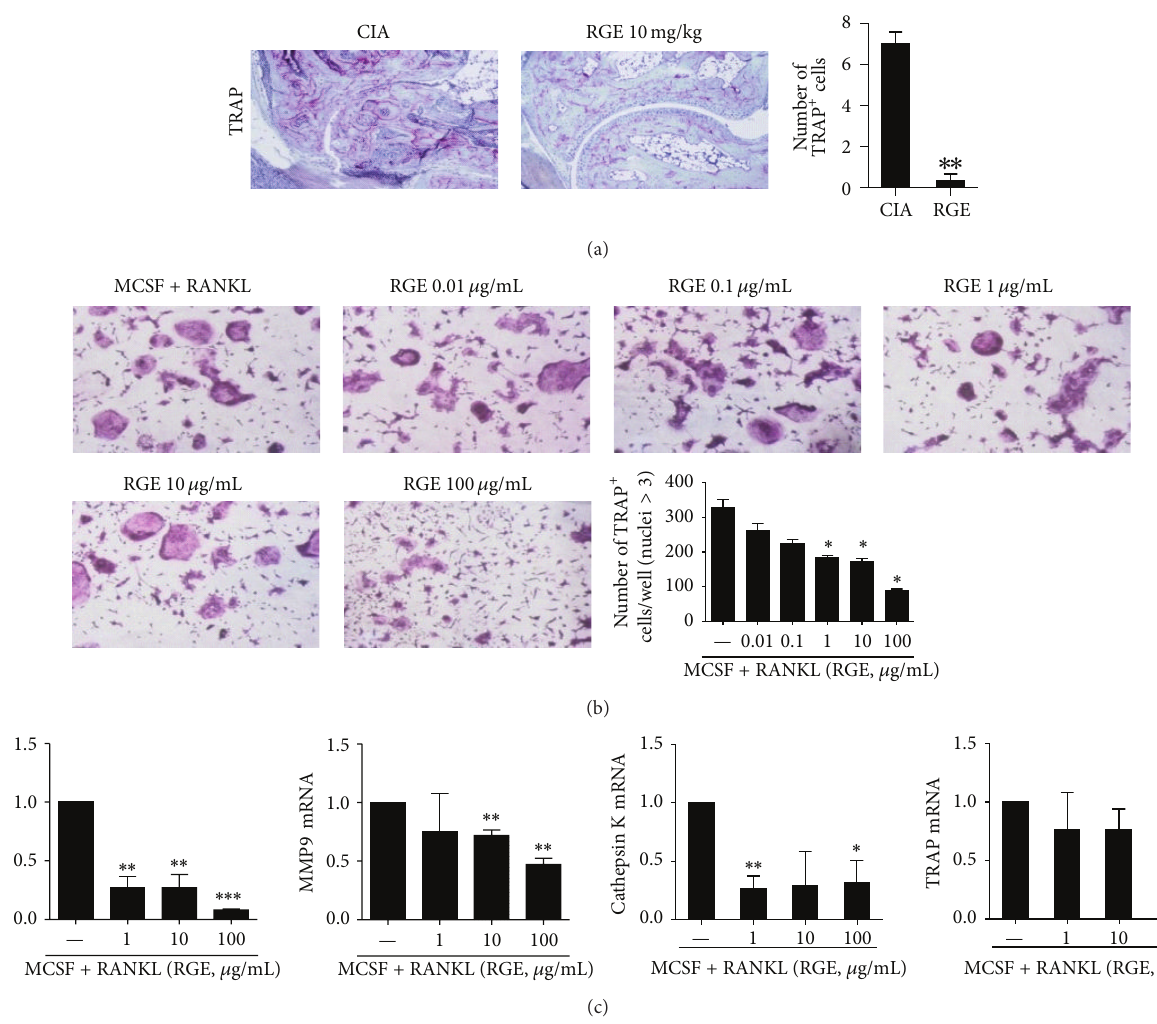
Figure 4: Red ginseng extract inhibits osteoclastogenesis in CIA mice. (a) The number of TRAP + cells in the arthritic joint of red ginseng extract (RGE) or CIA was counted using light microscopy. The BMM cells from the DBA/1J mice were cultured with M-CSF (10ng/mL) and RANKL (50ng/mL) in the presence or absence of various concentrations of RGE. (b) Cells were fixed and stained for TRAP (original magnification, × 100). The number of TRAP + cells was counted using light microscopy. The representative photographs from each group are shown. (b) The mRNA expressions of various osteoclastogenic markers such as RANK, MMP9. Cathepsin K and TRAP were analyzed using real time PCR. BMM: bone-marrow-derived monocyte/macrophage; MMP9: matrix metalloproteinase 9. Data are presented as the mean